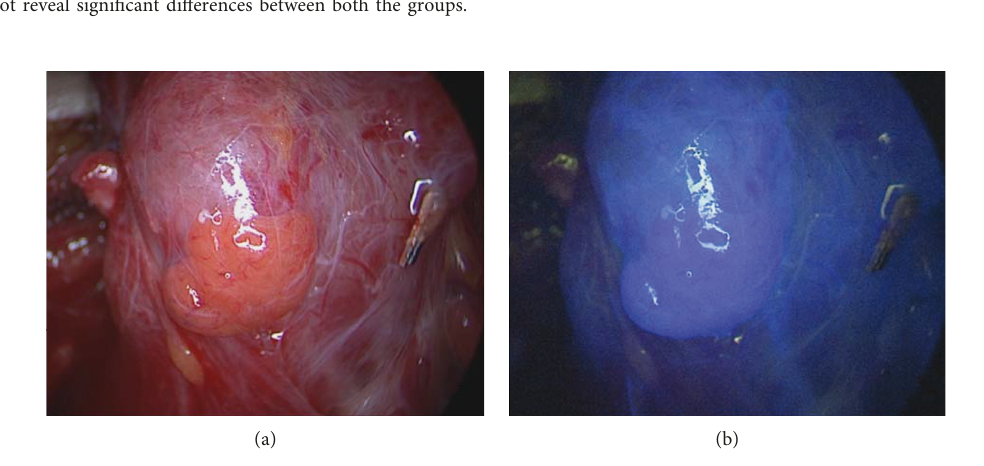
Figure 2: Parathyroid gland exposed to normal white light (a) and near-infrared light 2min after i.v. application of 5mg ICG (b). The gland displays a strong fluorescence indicating a good vascularity. The surrounding structures, especially the thyroid, are less fluorescent.